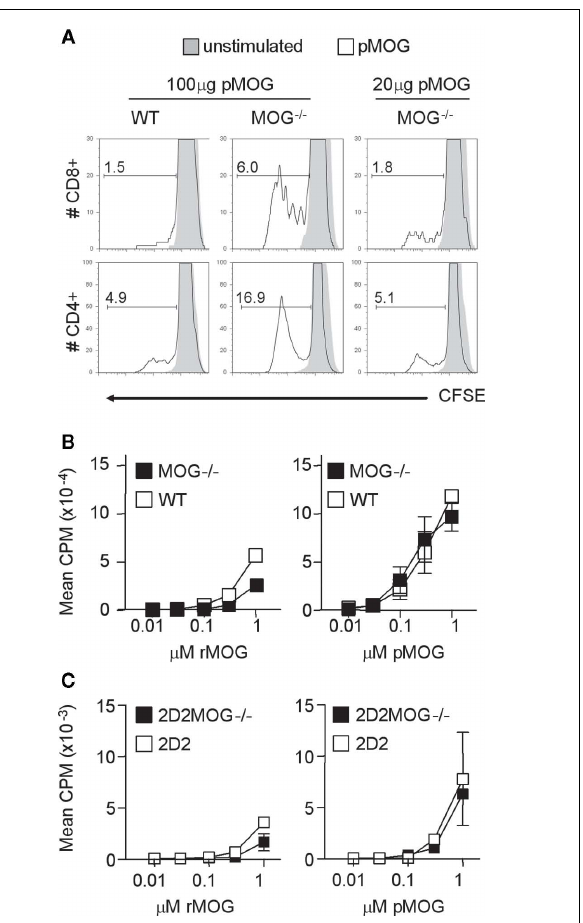
FIGURE 3 | Both CD4 + and CD8 + T cells respond to MOG(35–55). Mice were immunized with either 100 μ g or 20 μ g pMOG in CFA.Ten days later, draining LN cells were stained with CFSE and cultured with or without pMOG. CFSE dilution was analyzed on day 3 of culture in CD4 + and CD8 + T cells (A) , percentages represent the frequency of gated cells that had diluted CFSE. Results shown are one of three experiments giving consistent results; three mice per group were used. CD4 + T cell lines developed from pMOG-immunized mice were tested for recall responses to rMOG or pMOG (B) . Naive CD4 + T cells from 2D2 and 2D2MOG − / − mice were tested for primary in vitro responses to rMOG and pMOG (C)